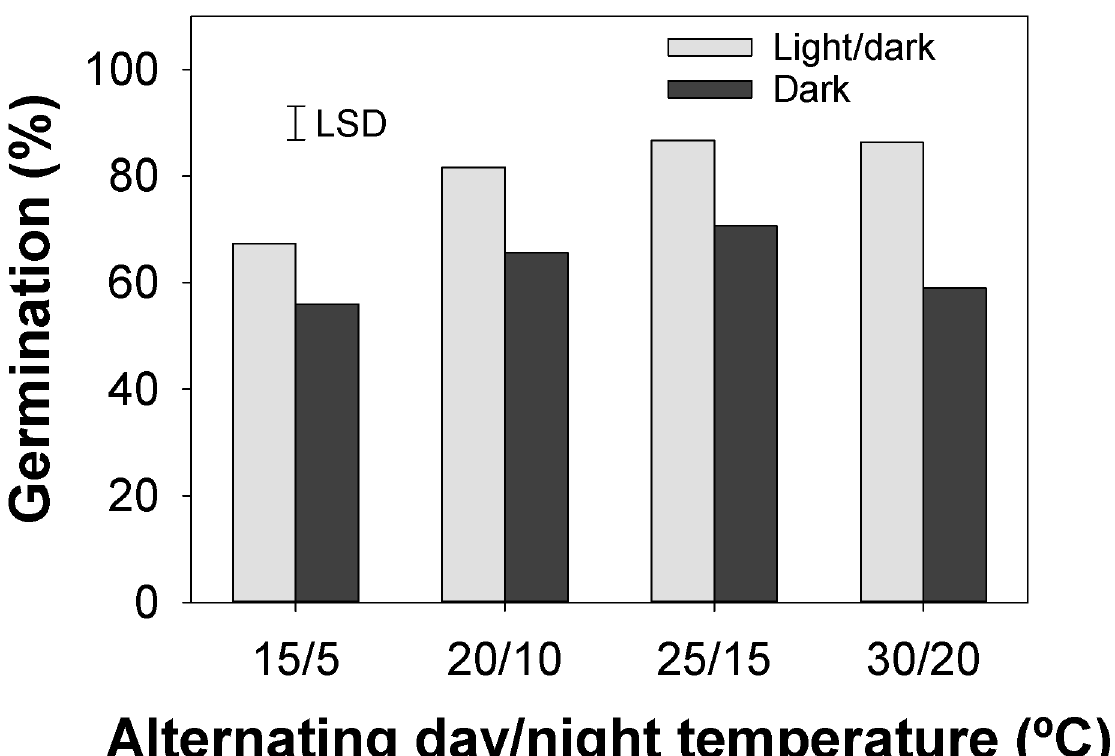
Fig 1. Effect of alternating day/night temperatures and light regimes on seed germination of Chloristruncata after 21 d of incubation.